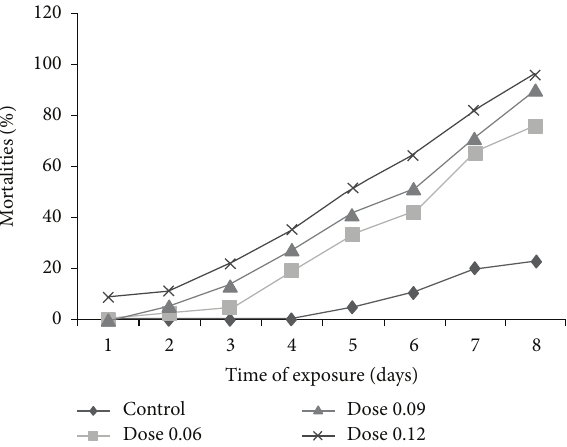
Figure 3: Variation of in vivo mortalities of R. lunulatus in terms of time and doses of the oil of C. ambrosoides leaves in soap.